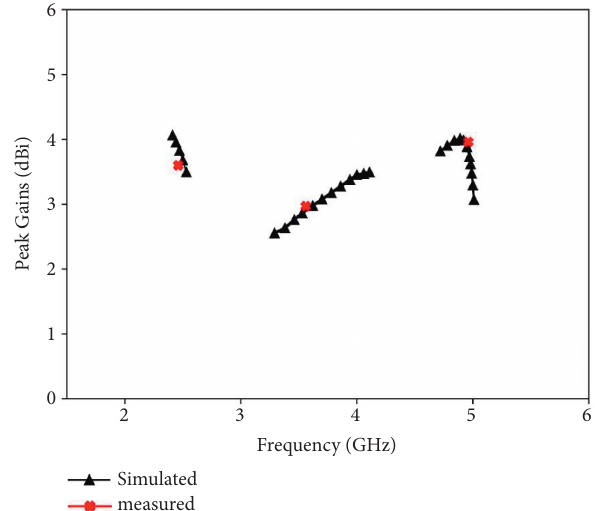
Figure 9: Simulated and measured peak gains at different operating bands. Table 2: Comparison of the proposed antenna with other previously reported antennas.